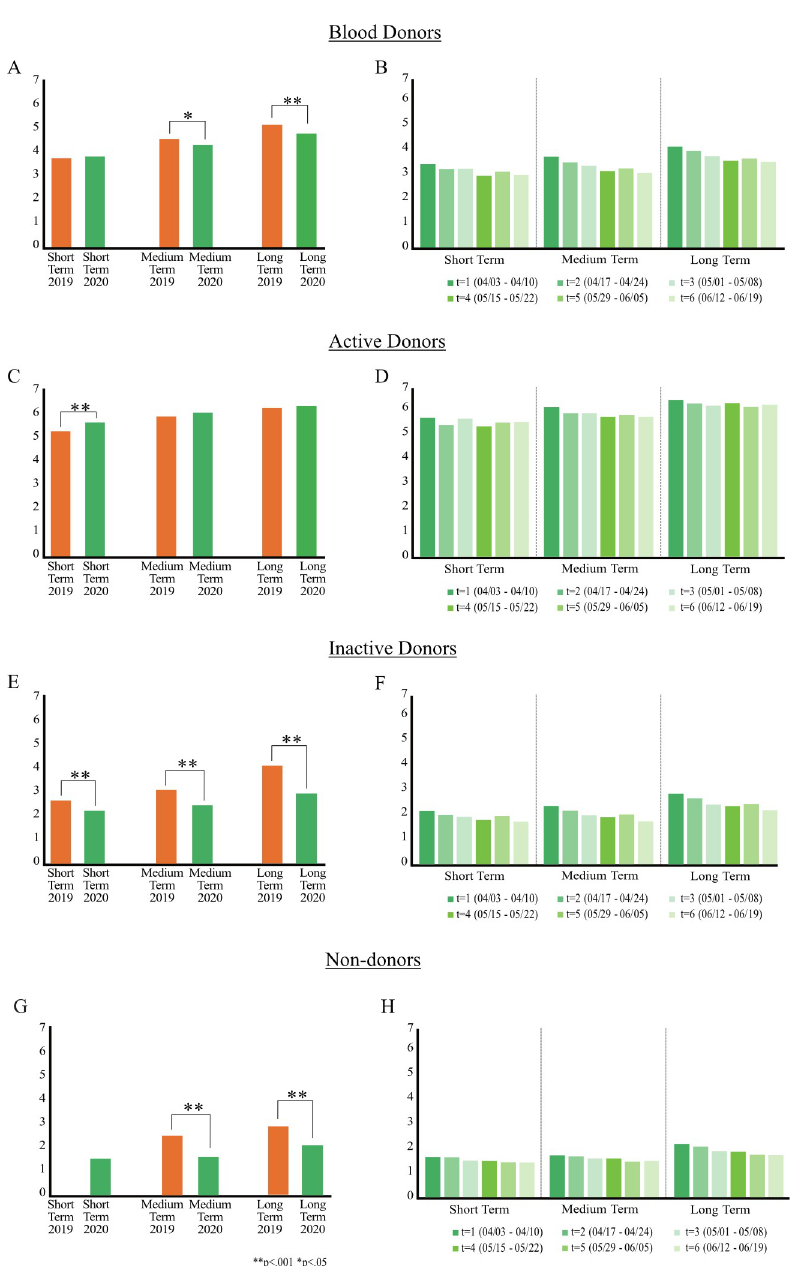
Fig 1. Effect of COVID-19 on blood donation intentions. (A) Comparison of reported mean values by blood donors (overall) between pandemic phase (t 1 , 2020/04) and pre-pandemic (2019/04). Significant changes are marked. (B) Reported mean values by blood donors (overall) within the pandemic phase (t 1 to t 6 ). (C) Same as (A) only for active donors. (D) Same as (B) only for active donors. (E) Same as (A) only for inactive donors. (F) Same as (B) only for inactive donors. (G) Same as (A) only for non-donors. (H) Same as (B) only for